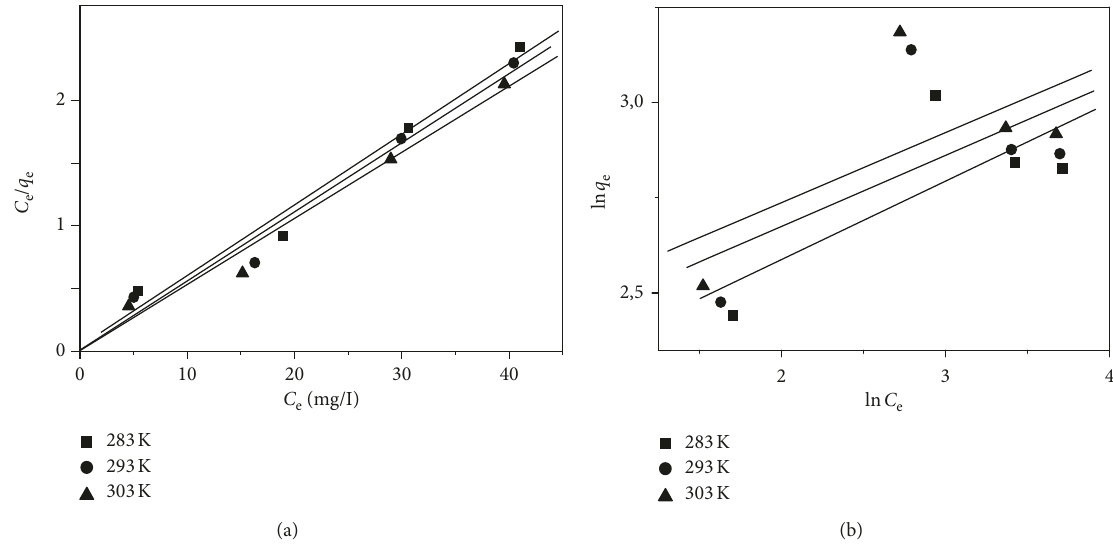
Figure 12: Plots of Langmuir (a) and Freundlich (b) isotherms in linear form for the adsorption of As(V) onto Fe-B at several temperatures.